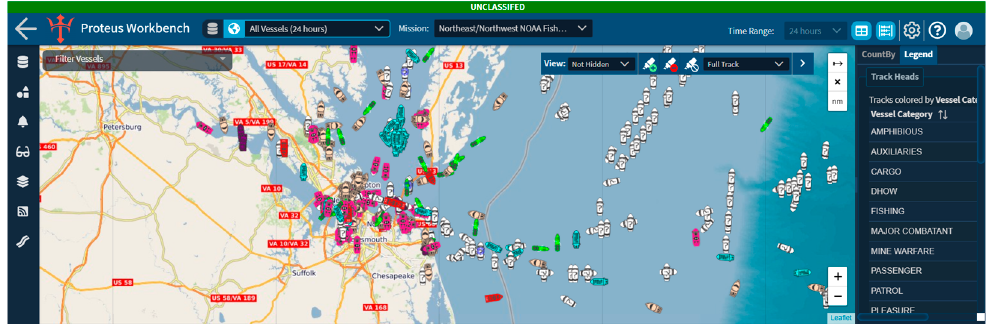
Figure 10. The Maritime Domain Awareness (MDA) platform, Proteus, demonstrating the last 24 hours of vessel activity at the mouth of Chesapeake Bay on 30 June 2022.